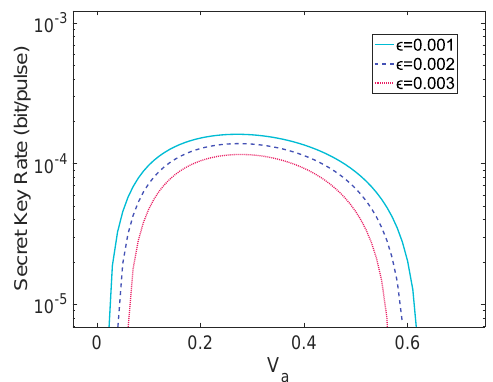
Figure 3. When d = 110 km, the relationship between V a and secret key rate with different values of (cid:101)